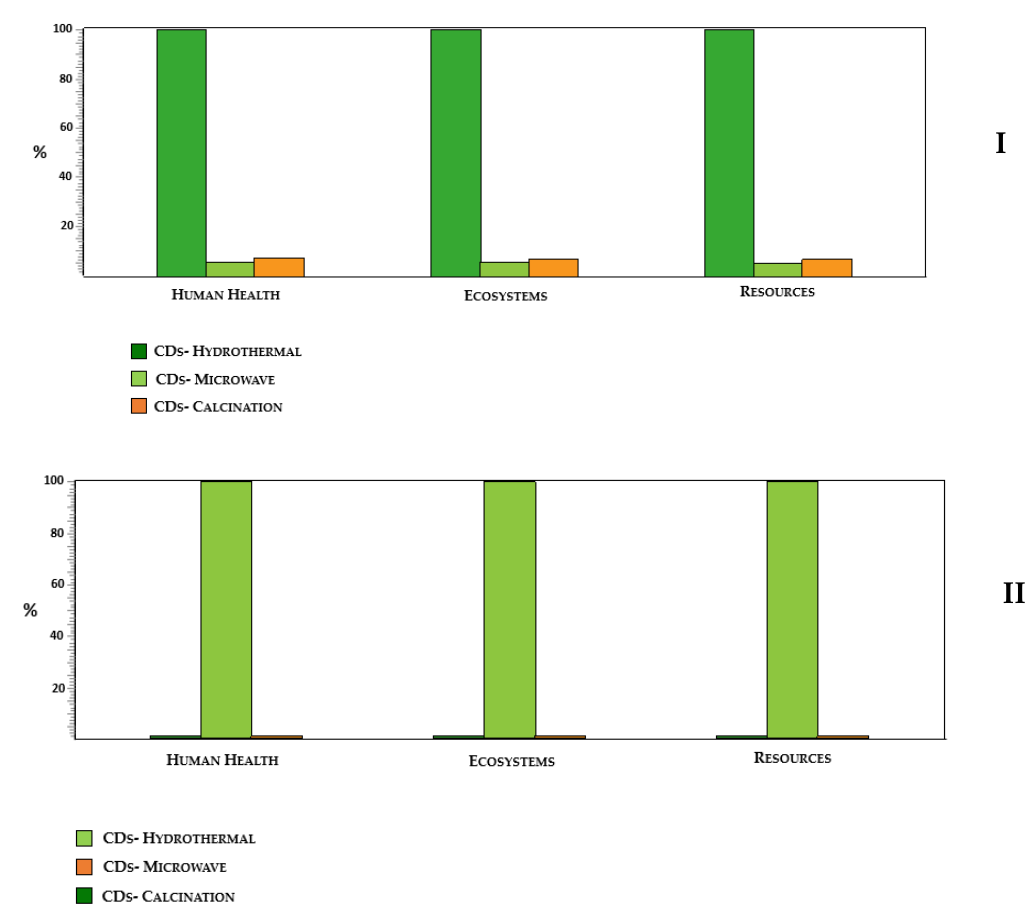
Figure 4. Comparative damage assessment for all three syntheses using ( I ) reaction yield and ( II ) quantum yield (QY) unit.